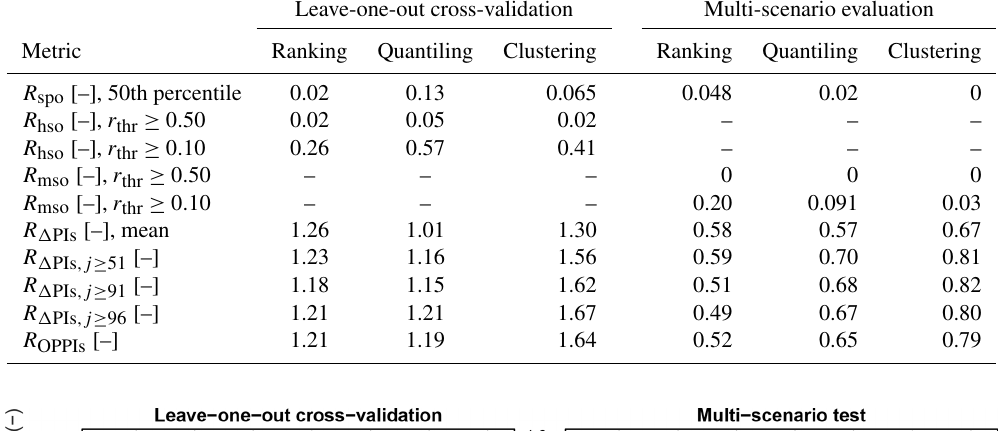
Table 3. Metrics of the behaviour of the approach for three methods of selecting representative parameter sets and the predictive intervals in the leave-one-out cross-validation and in the multiple-scenario evaluation. The values represent the median values over all 100 scenario runs. Leave-one-out cross-validation Multi-scenario evaluation